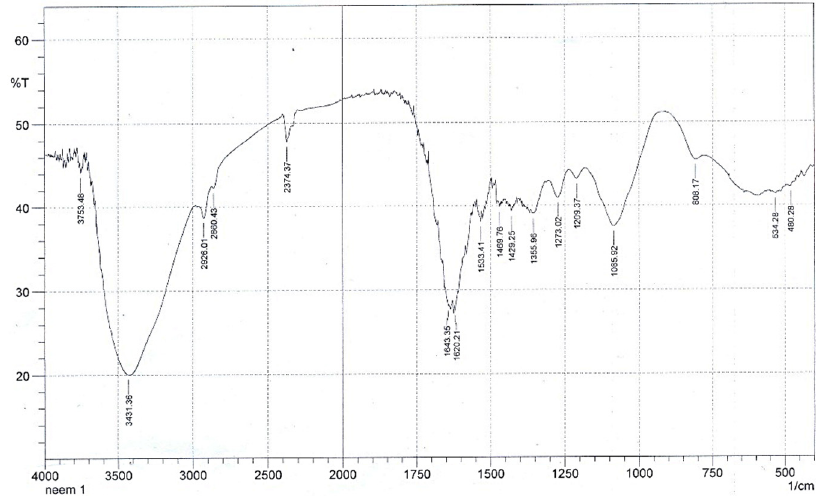
Figure 1. FTIR spectrum of the IZNC.